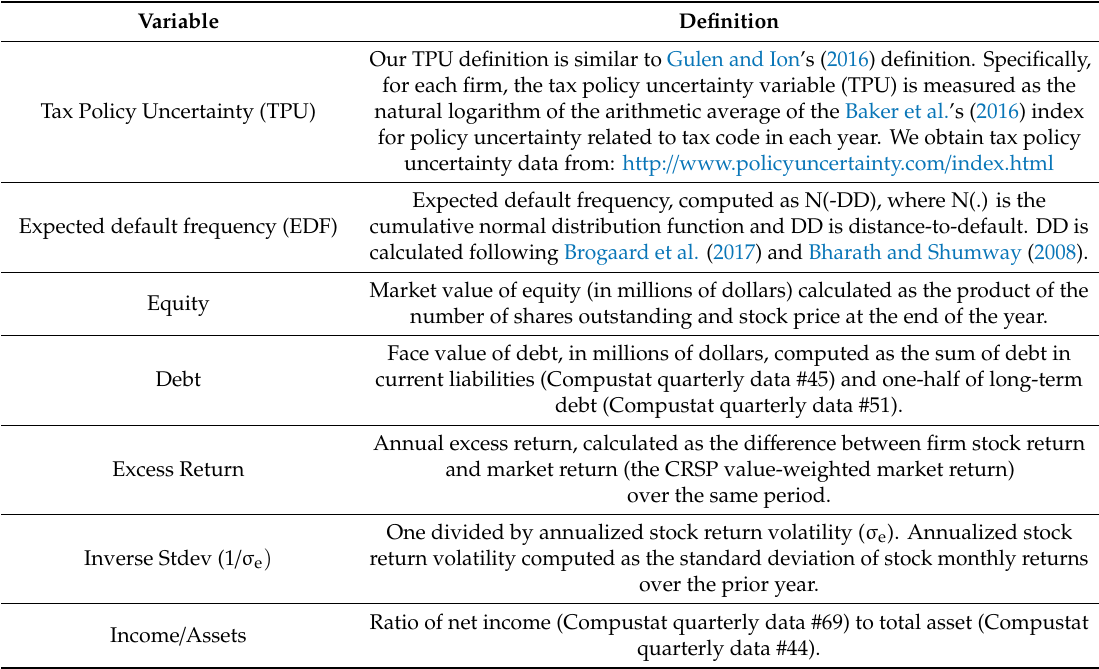
Table A1. Variable